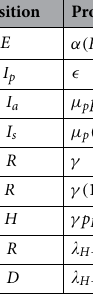
Table 1. Transition probabilities for the diffusion model.